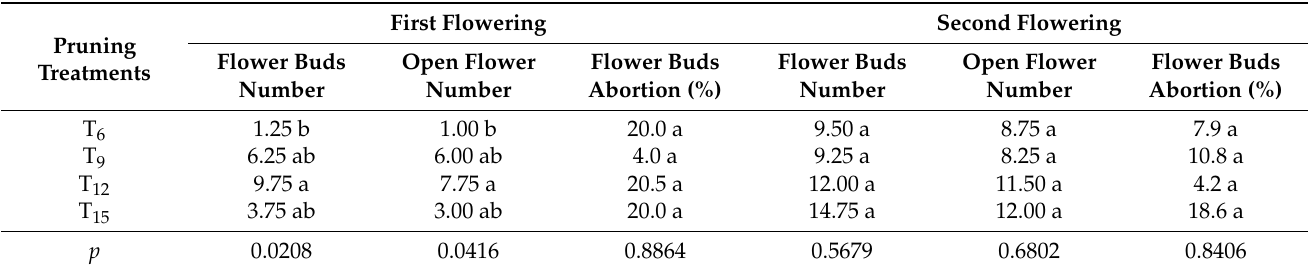
Table 1. Flower buds and open flowers number, and flower buds abortion in response to pruning treatments in the first (June) and second (August) flowering waves.